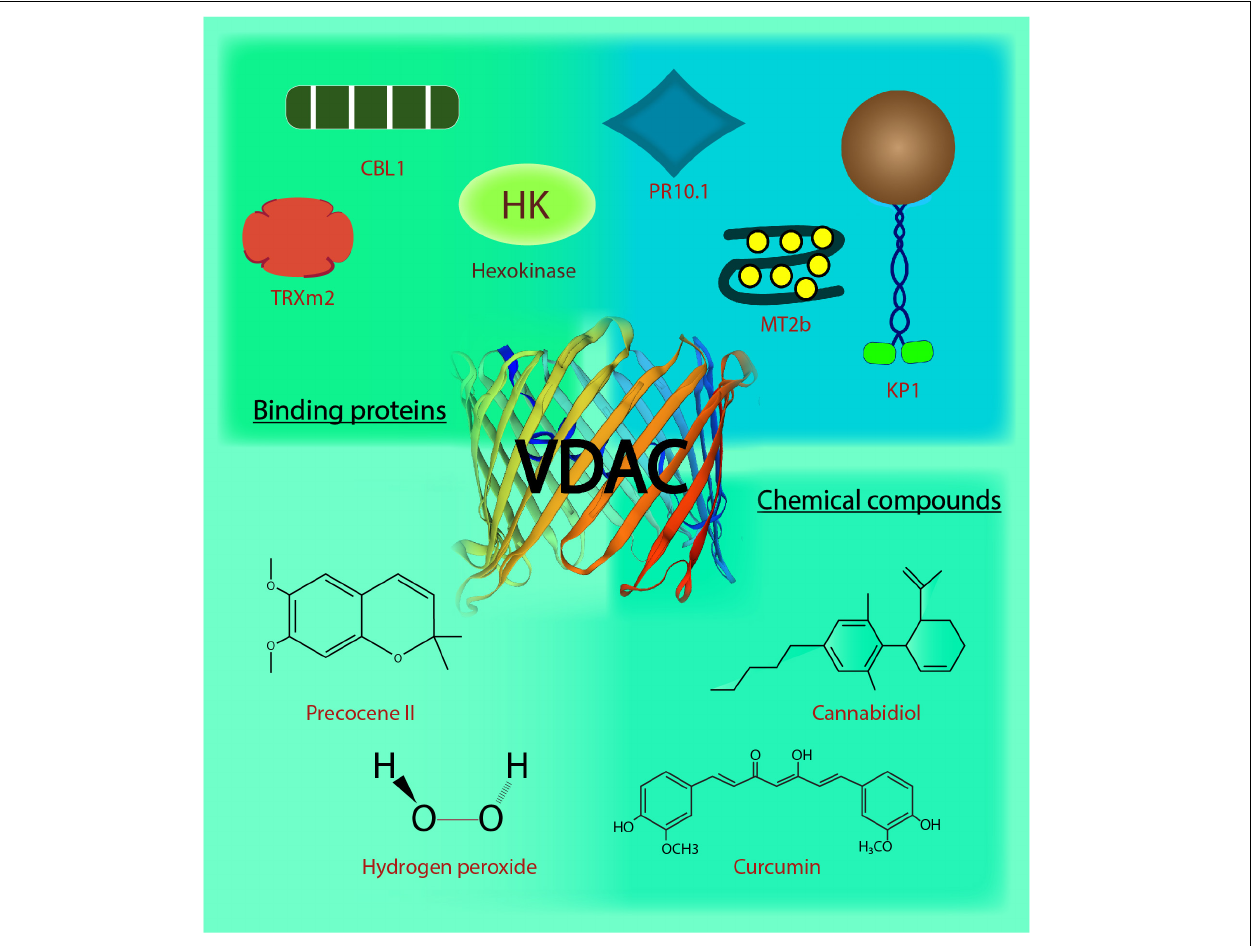
FIGURE 1 | Voltage-dependent anion channels in plants. The biochemical action and interaction of VDACs in plants affects their functional behavior. This image depicts the regulation and interaction of VDACs with binding proteins and chemical compounds. CBL1, Calcineurin B-like protein; TRXm2, chloroplast protein thioredoxin m2; MT2b, metallothionein 2b; H 2 O 2 , hydrogen peroxide; KP1, plant kinesin protein 1; PR10.1, pathogenesis-related 10.1; C 13 H 16 O 3 , precocene II; C 21 H 20 O 6 , curcumin; C 21 H 30 O 2 ,